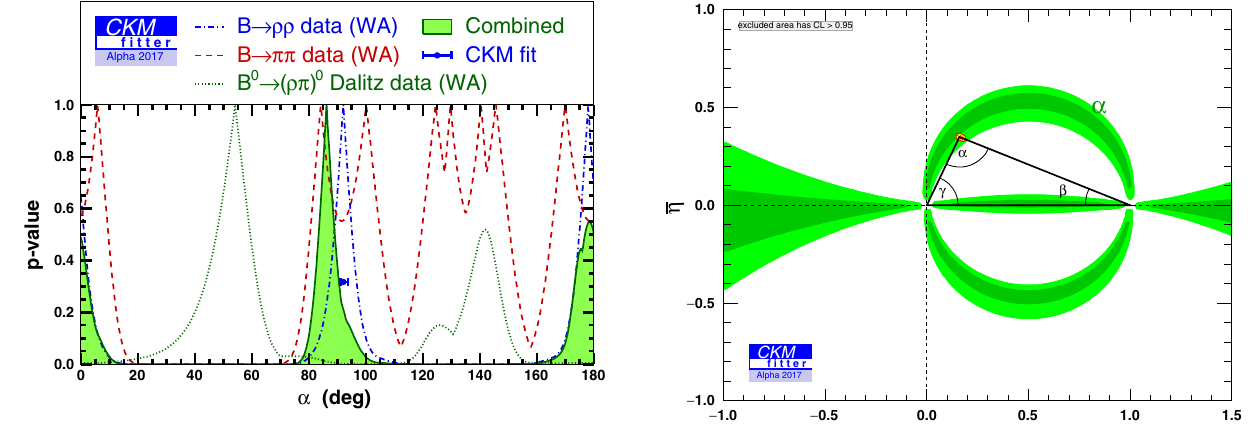
Fig. 10 SU ( 2 ) constraint on α ( green shaded area ) from the combi- nation of B → ππ ( dashed line ), B → ρρ ( dashed-dotted line ) and B 0 → π + π − π 0 Dalitz analyses ( dotted line ) compared to the indirect value ( dot ) obtained from the global CKM fit [18]